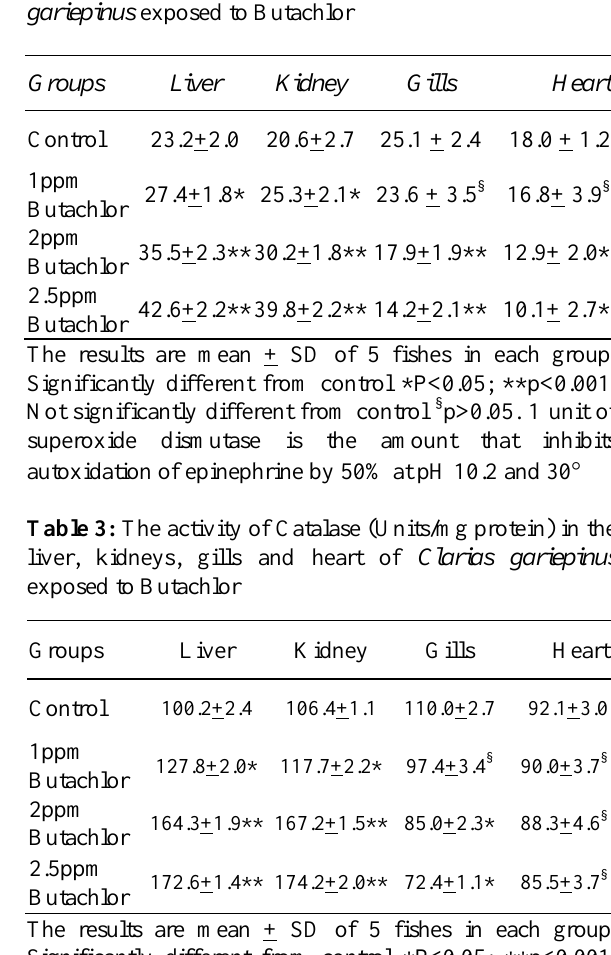
Table 2: The activity of Superoxide dismutase (Unit/mg protein) in the liver, kidneys, gills and heart of Clarias gariepinus exposed to Butachlor